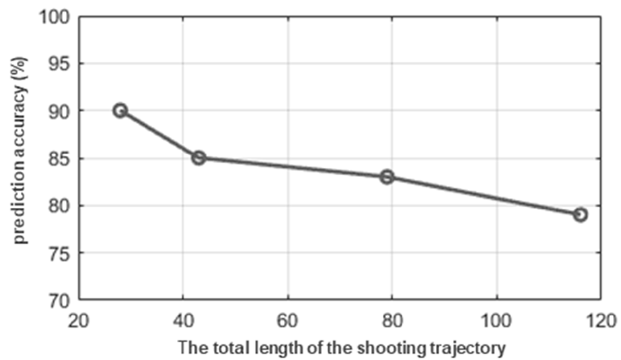
Figure 8. Prediction results under different interpolation points.